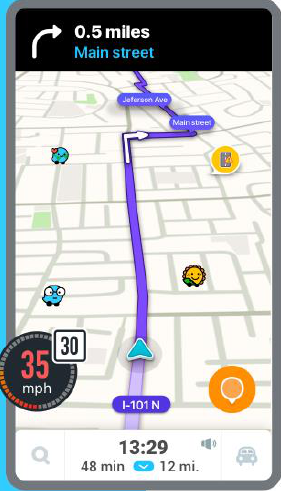
Figure 3 . Speedometer helps you stay within the speed limit.